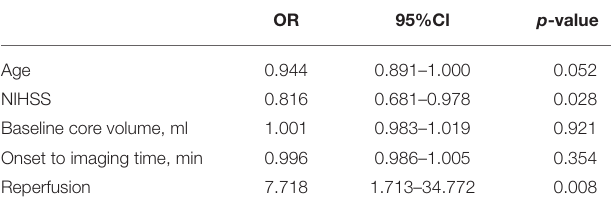
TABLE 4 | Multivariate regression analysis of independent predictors for good outcome (mRS < 3). OR 95%Cl p